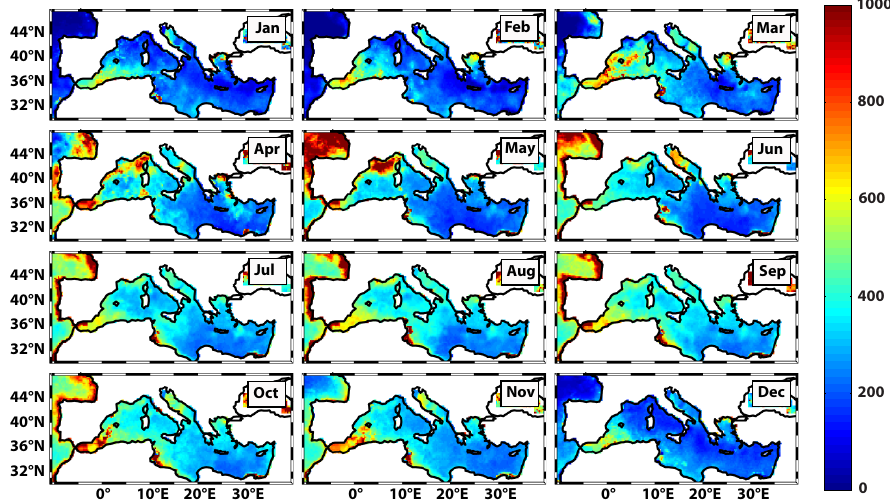
Fig. 4. Monthly averaged (from 2005 to 2007) net primary production (NPP) in units of mg Cm − 2 day − 1 from the Carbon-based Production Model (CbPM) based on input from